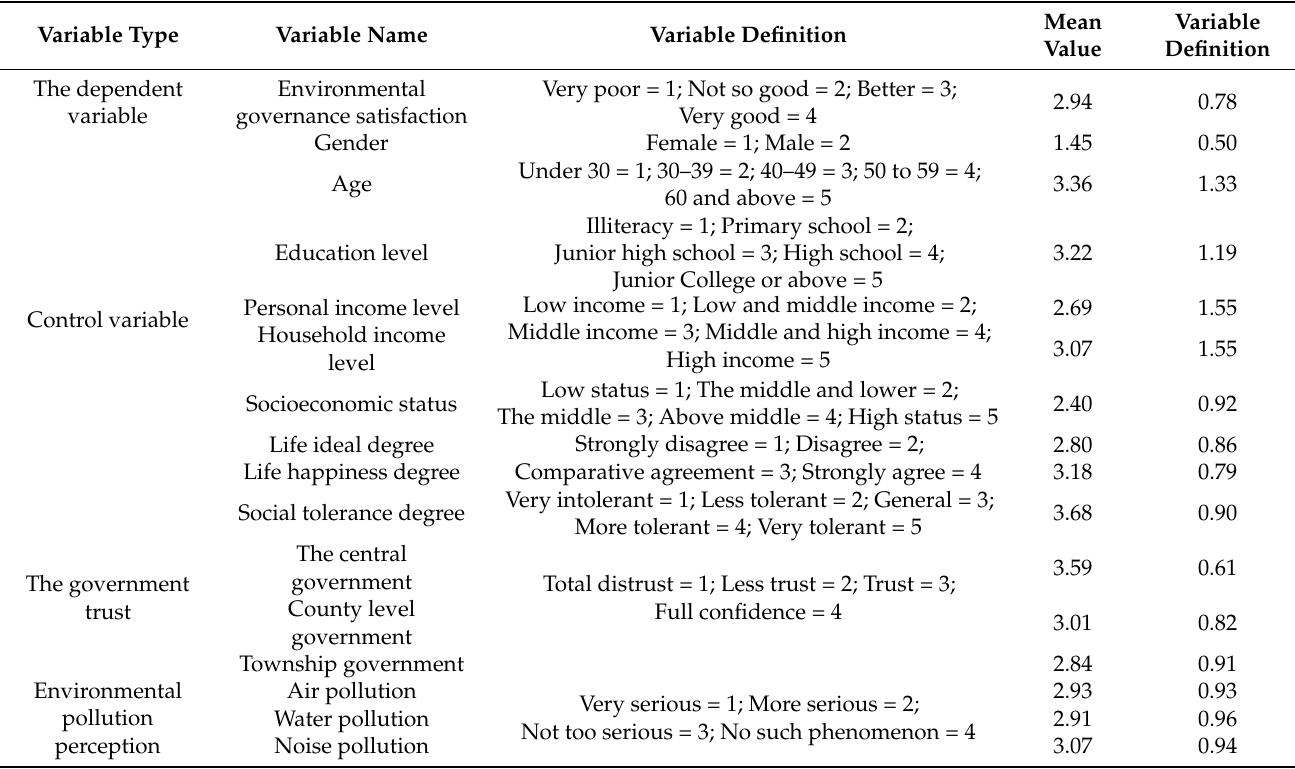
Table 2. Variable definitions and